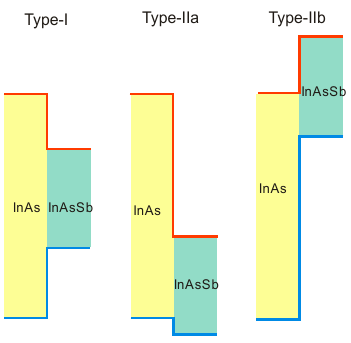
Figure 8. Three possible band alignments between InAs and InAs 1-x Sb x .